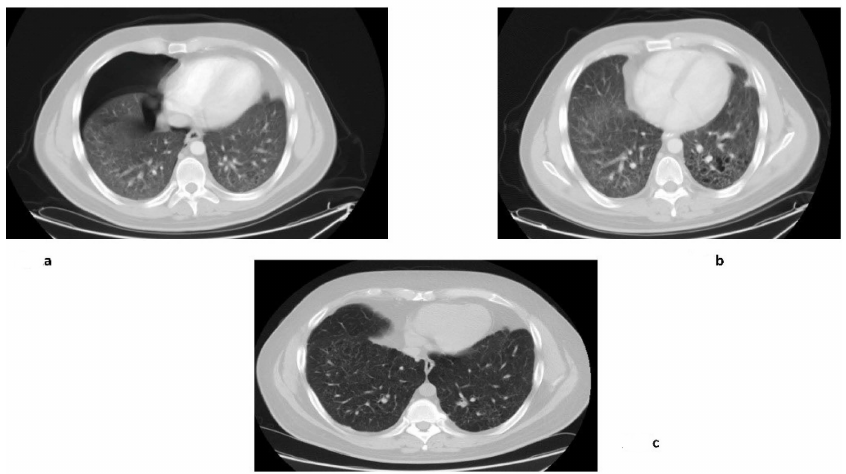
Figure 2. In these pictures, the response obtained with imatinib in Patient n.1 is reported: ( a ) Computed tomography of the chest shows the basal condition of the patient with pneumothorax; ( b ) Improvement after one year of treatment; ( c ) Maintained response ten years